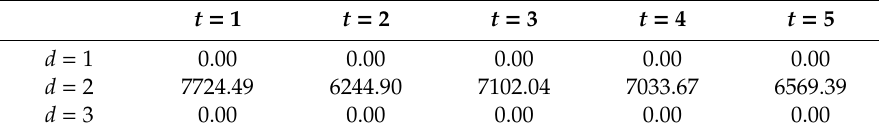
Table 21. Inventory level at each distribution center in each time period.